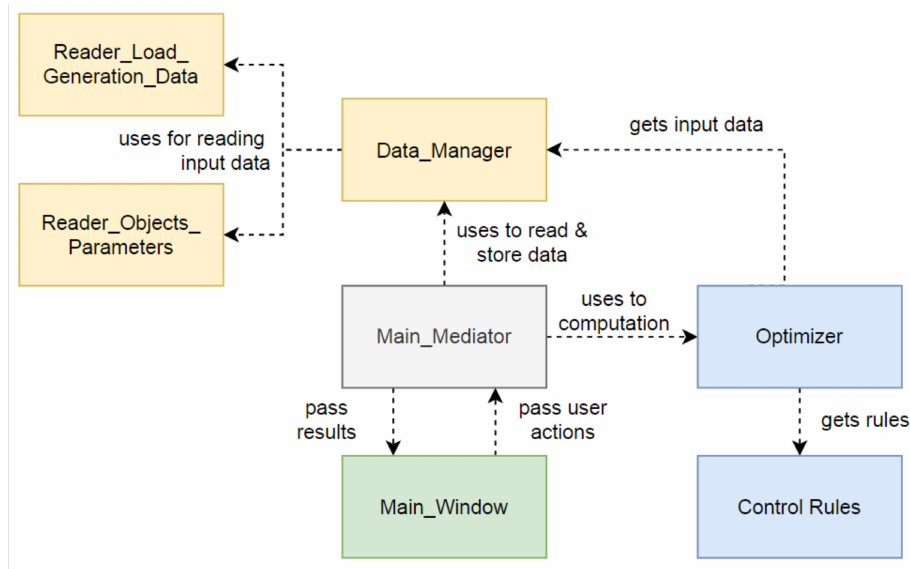
Figure 5. The UML class diagram of the developed software. There are three main modules: Data (pale orange color), Graphical User Interface (light